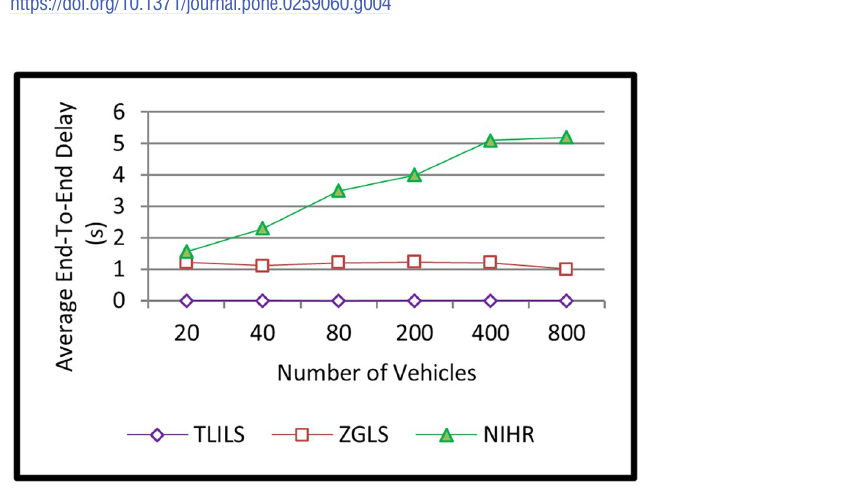
Fig 5. Information dissemination delay of the TLILS, ZGLS, and